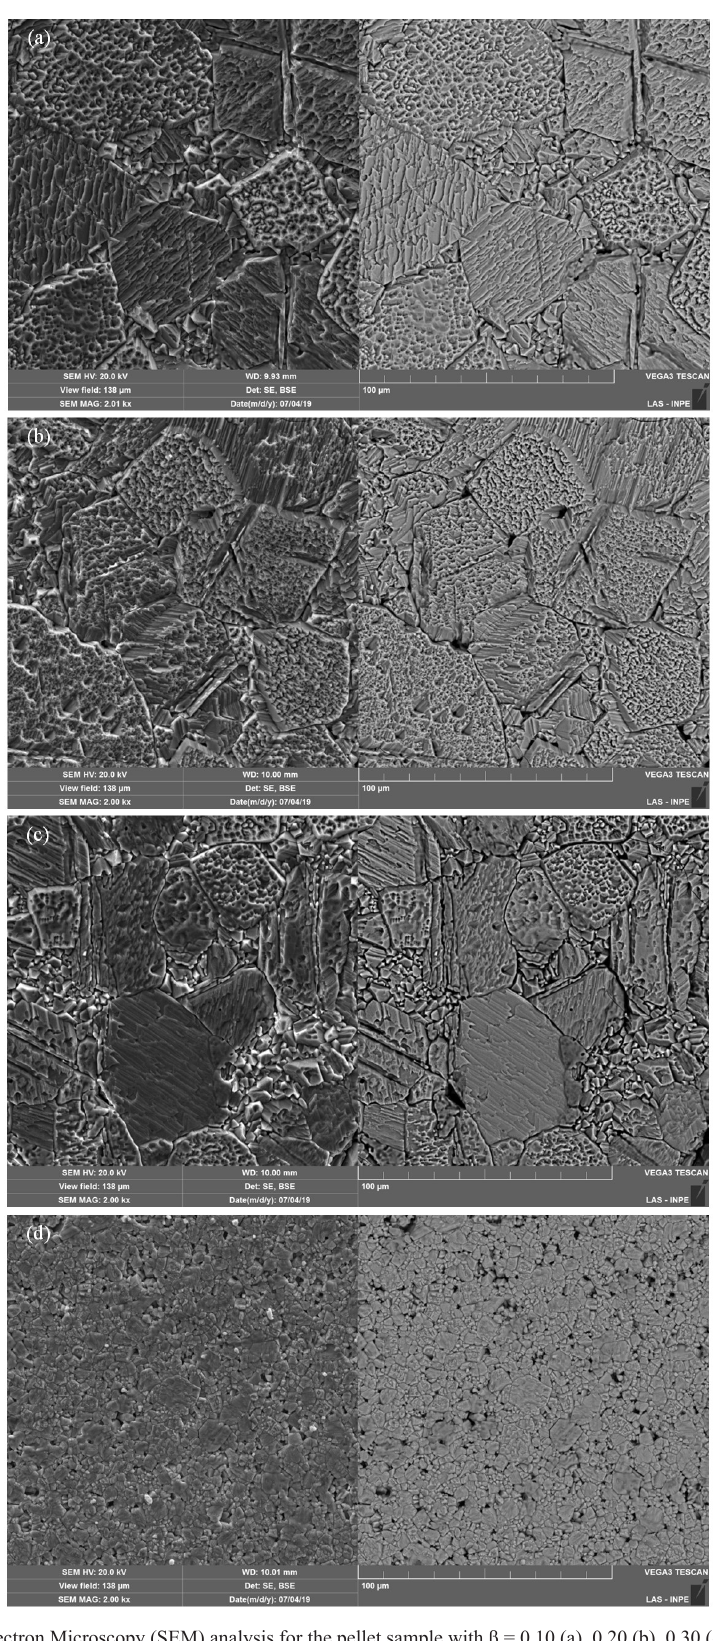
Figure 6. Scanning Electron Microscopy (SEM) analysis for the pellet sample with β = 0.10 (a), 0.20 (b), 0.30 (c) and 0.40